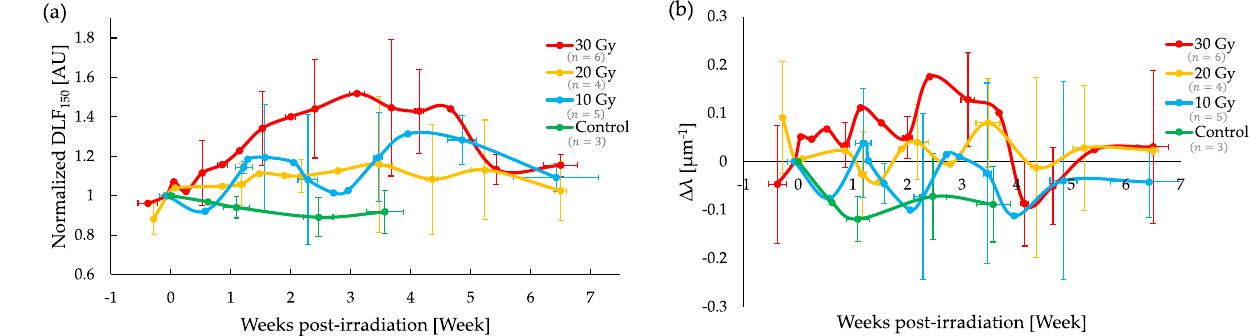
Figure 4. Temporal trends in DLF 150 and (cid:31) of tumour vascular networks differ as a function of radiation dose: ( a ) Normalized DLF 150 , plotted here as the ratio DLF 150 ( t )/ DLF 150 ( 0 ) , with DLF 150 ( 0 ) being the pre-irradiation (cid:31) ( t ) (cid:31) ( 0 ) in the convexity index relative to its pre-irradiation value, (cid:31) ( 0 ) . value; ( b ) the change � (cid:31) ( t ) ≡ − 5 7 weeks post irradiation; the Initially, both DLF 150 and (cid:31) increase before returning to baseline levels at ∼ − convexity index behaviour seems “noisier” with significant temporal fluctuations. For further trends elucidation, see text. Symbols are experimental points and lines are a guide for the eye; error bars represent standard deviations amongst the different treatment